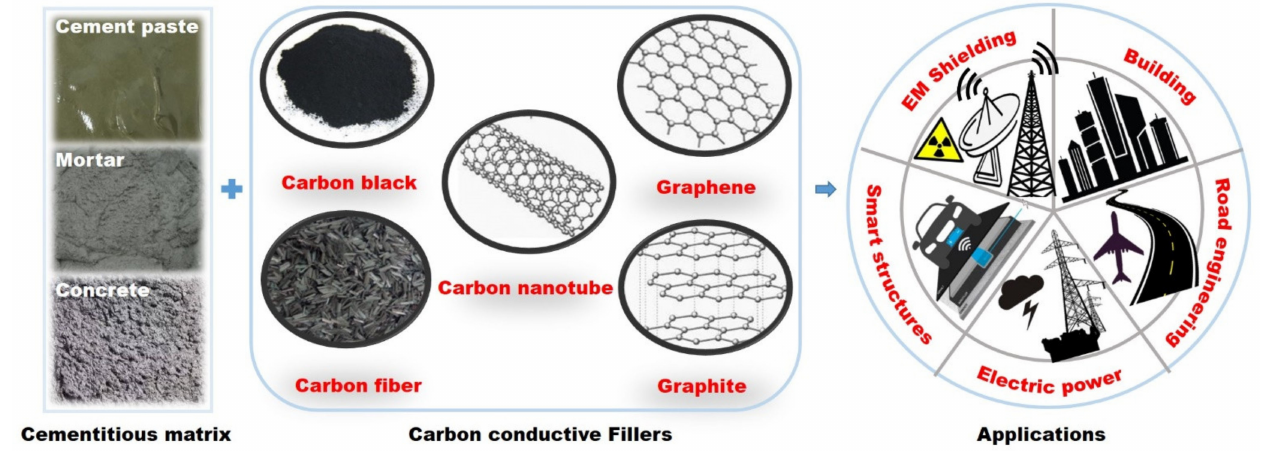
Figure 1. Potential applications of conductive carbon material within ECCCs.